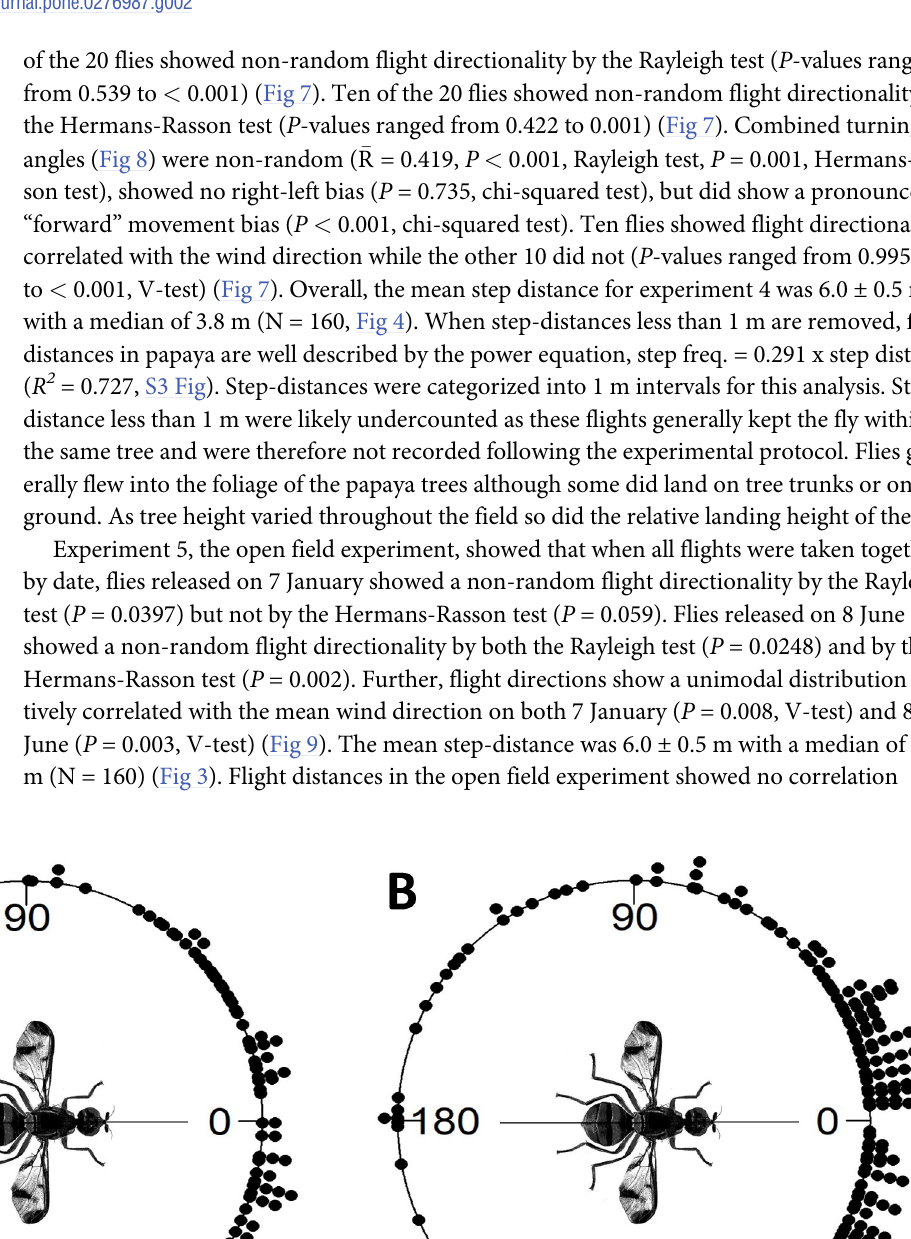
Fig 2. Flight directions and lengths of HR tagged Zeugodacus cucurbitae for experiment 2 (field cage). Each replicate consisted of a series of 10 flights with a single tagged fly. Blue arrows represent individual flights, while red arrows show the mean flight direction and length.